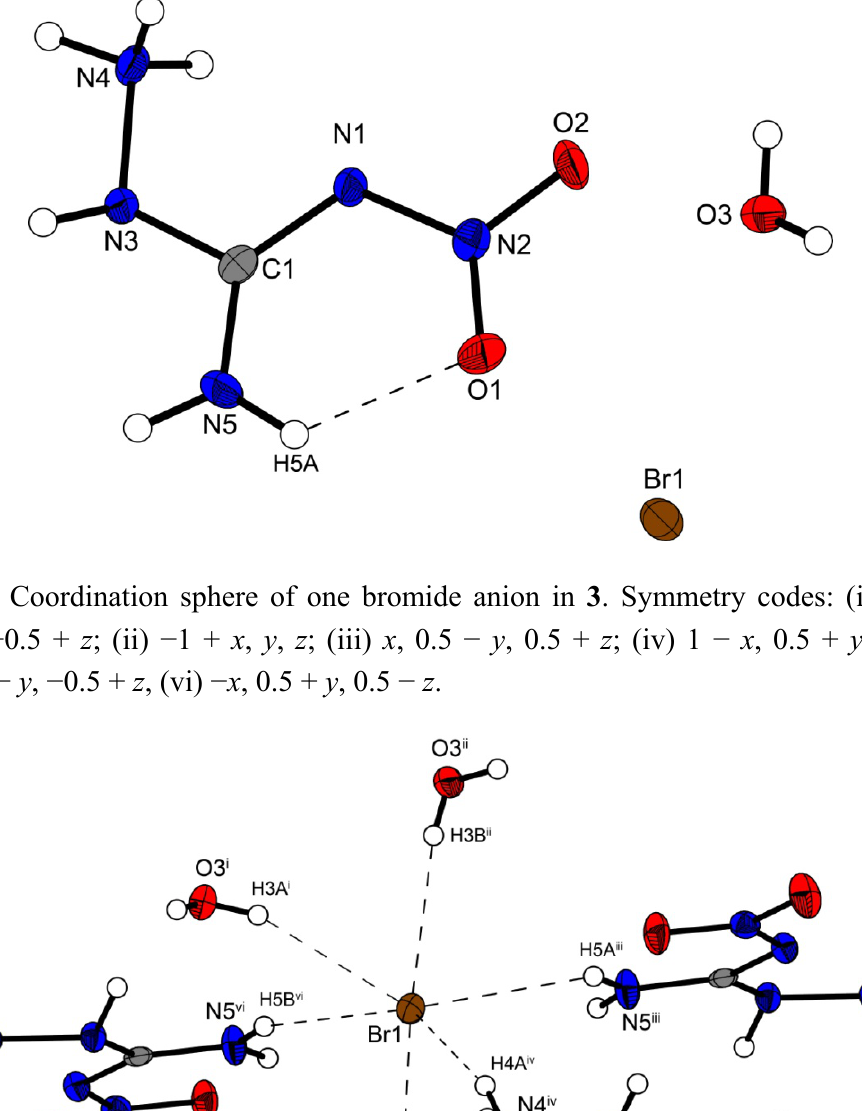
Figure 4. Molecular structure of amino-nitro-guanidinium bromide monohydrate ( 3 ). Ellipsoids are drawn at the 50% probability level.